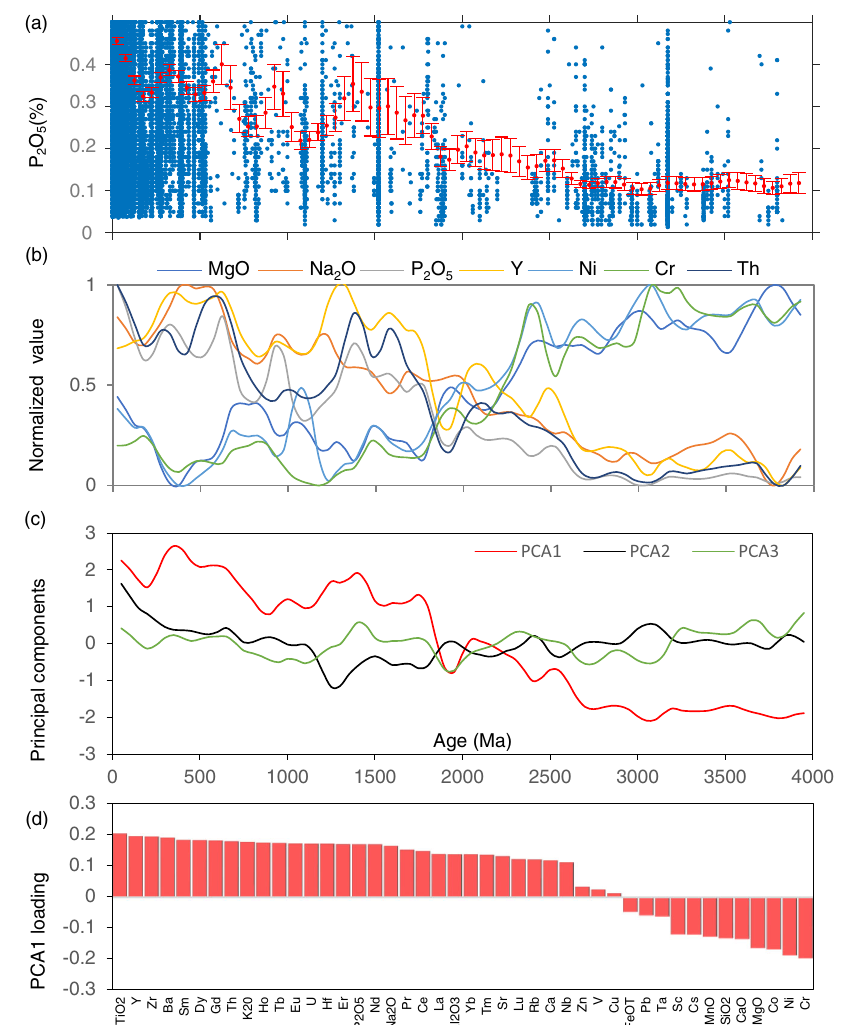
Fig. 3 | Igneous geochemistry big data analysis. a Time series record of mean P 2 O 5 concentration in ma fi c igneous rocks across the last 4.0 Gyrs; blue circles represent individual values, and red circles are bootstrapped averages with error bars showing 2-SD (standard deviation) uncertainties. b Secular compo- sitionalevolutionofma fi ccompositionthroughtime;timeseriesvaluesofeach element ’ s concentration were normalized using max-min scaling